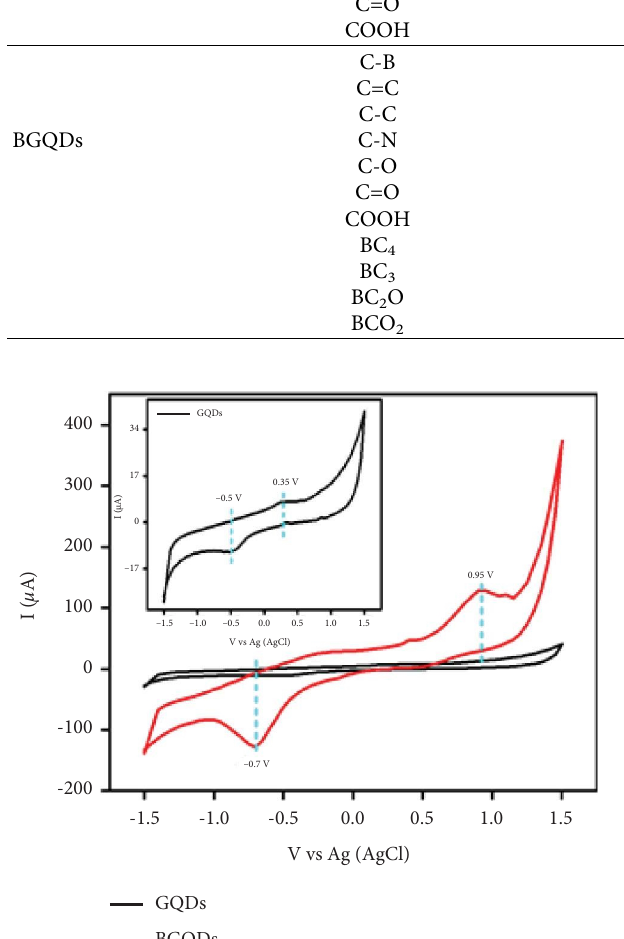
Figure 7: Cyclic voltammetry measurements of GQDs/GCE and BGQDs/GCE in 0.1M PBS vs. Ag/AgCl.